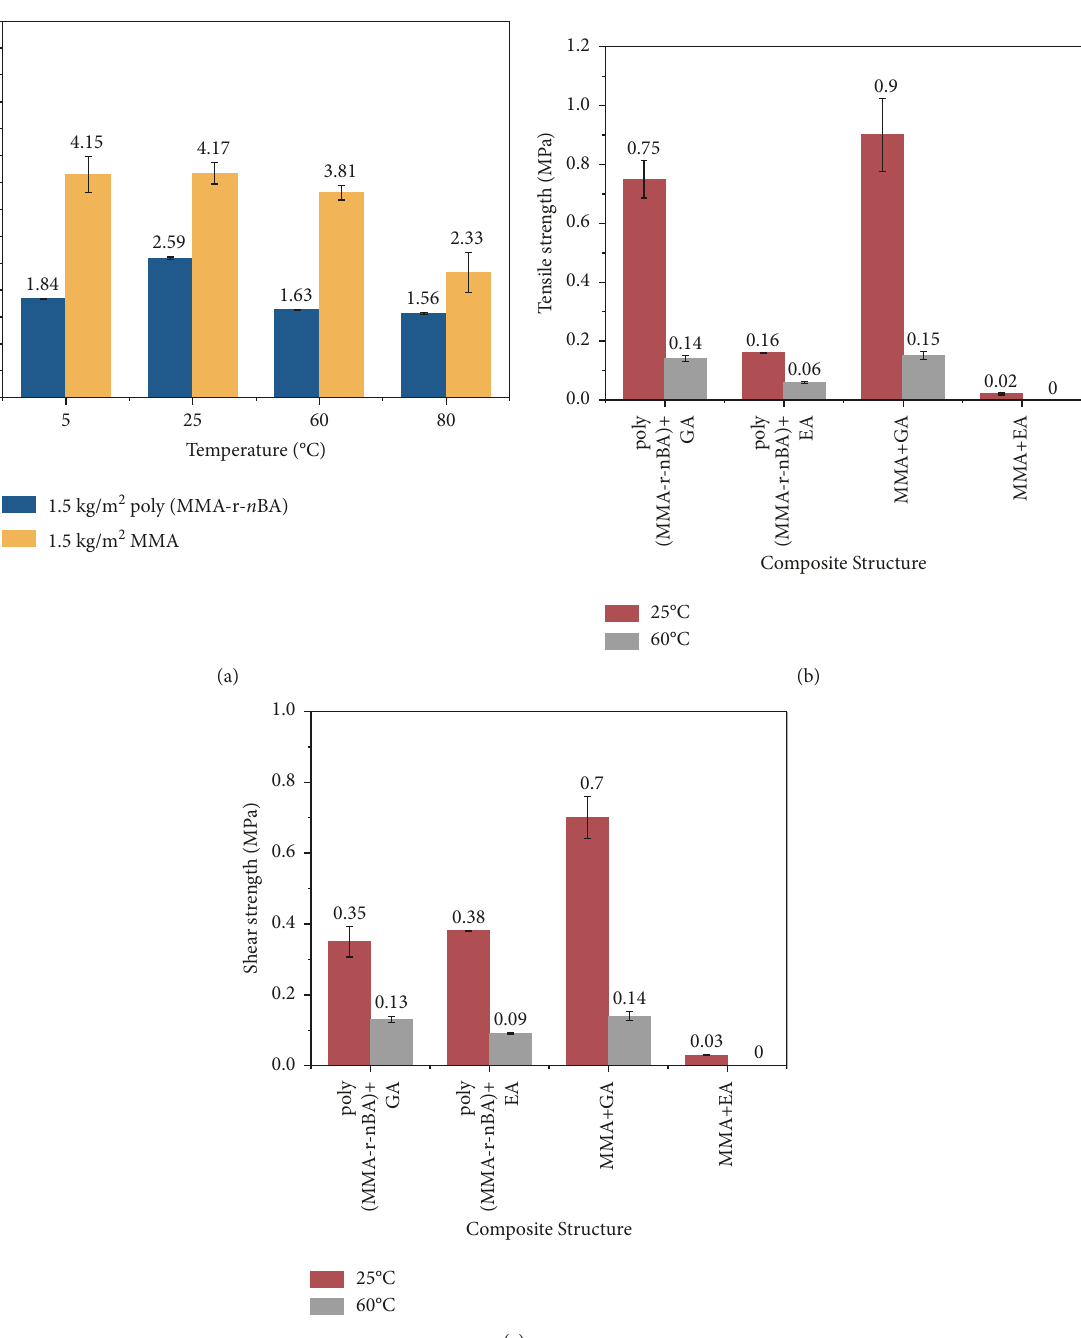
Figure 9: Comparison of adhesive and shear strengths between MMA and the poly(MMA-r-nBA) coatings. (a) The adhesive strength between the poly(MMA-r-nBA) coating and steel substrates (yellow columns) and, as a comparison, the results of MMA adhesive materials (blue columns) are listed. (b) The adhesive strength between the poly(MMA-r-nBA)/MMA coating and asphalt mixture (GA and EA). (c) The shear strength between the poly(MMA-r-nBA)/MMA coating and asphalt mixture (GA and EA). Further details are given in Table